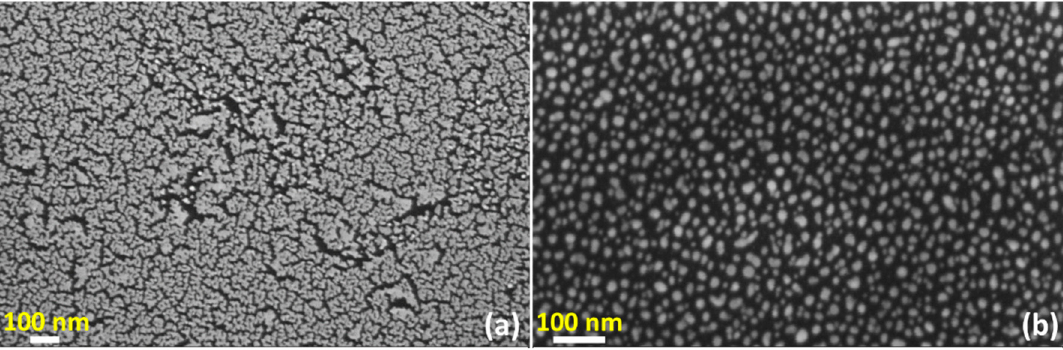
Figure 6. SEM images of ( a ) 2nm-Au and ( b ) 2 nm-Ag films deposited on epitaxial graphene. Copyright 2021 WILEY-VCH Verlag GmbH & Co. KGaA, Weinheim, Germany.